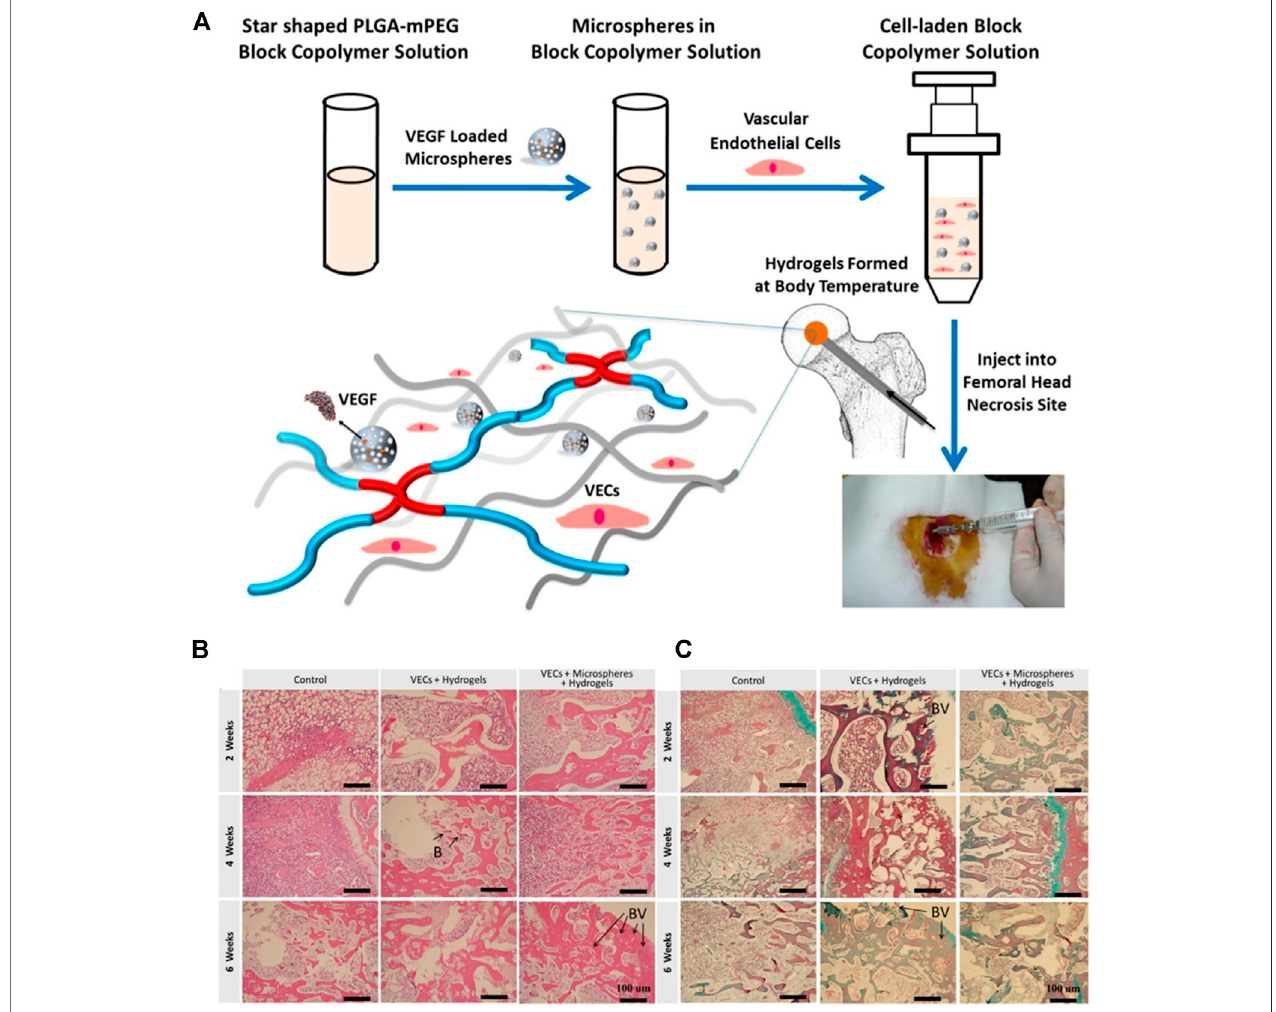
FIGURE 11 | Polymer scaffold carrying VEGF is bene fi cial to vascular regeneration during osteonecrosis. (A) Schematic illustration for preparation of injectable hydrogel composite withVEGF loaded microspheres and vascular endothelial cells. Representative histological evaluation ofcross sections retrieved at week2, 4 and 6 after implantation ofhydrogels composited with VEGFloaded microspheres. VEGFrefers tovascular endothelialgrowth factor, VECs referstovascular endothelial cells, (B) referstobloodcells,BVreferstobloodvessels.Theblackarrowreferstothepositionof (B) orBVinthe fi gures.Reproducedwithpermission(Chenetal.,2018). Copyright 2018, Elsevier